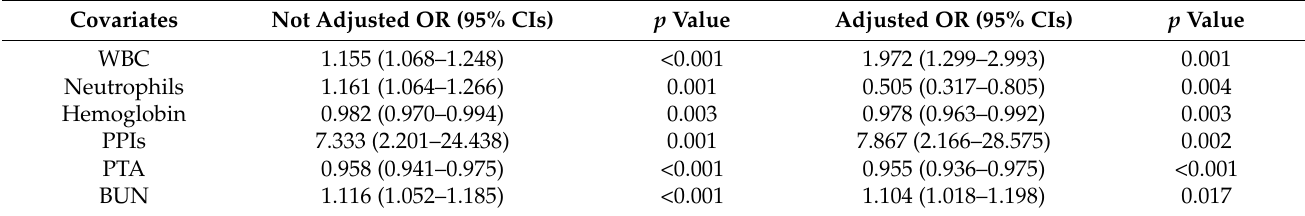
Table 4. Association between the development of HE and risk factors.